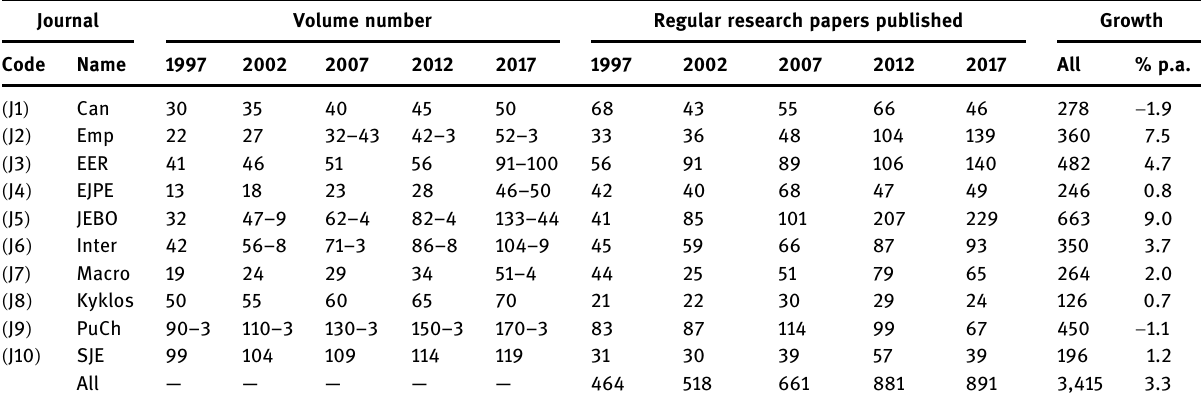
Table 4: The 10 journals